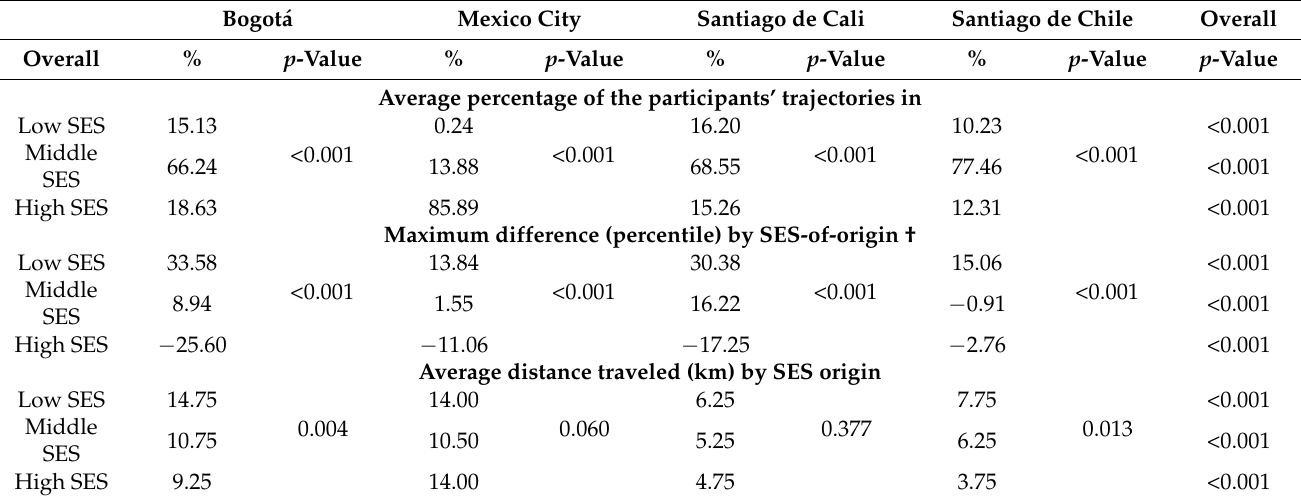
Table 5. Participants’ trajectories analyses by study